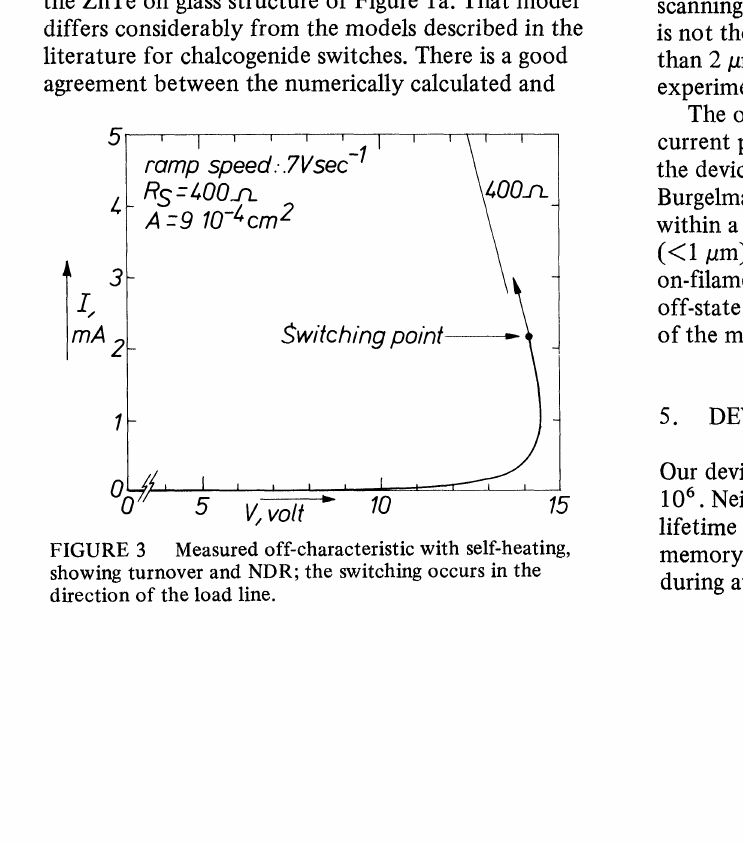
Switching polht